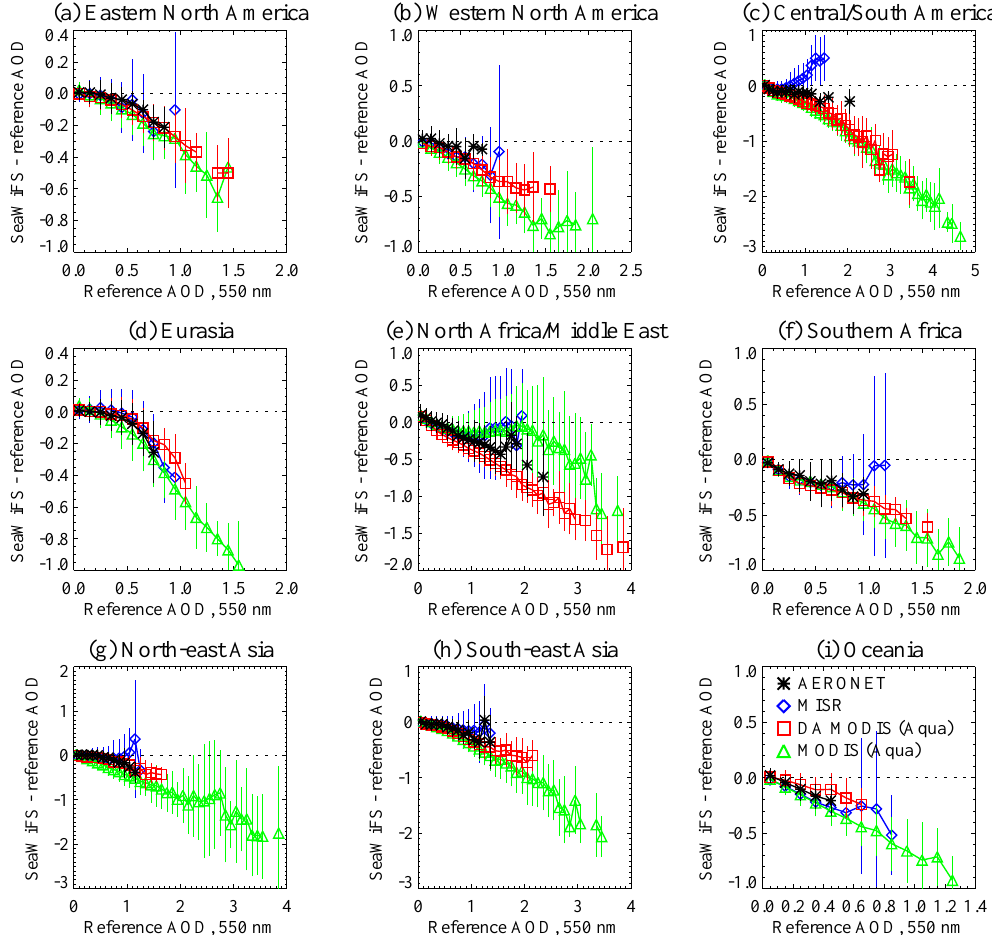
Fig. 10. Comparison between colocated SeaWiFS and other AOD data for each region (Fig. 1). Reference AOD datasets are binned in AOD increments of 0.1; symbols and lines show the mean and standard deviation of the difference between SeaWiFS and the reference AOD in each bin. Data are only shown for bins with at least five matched data points.